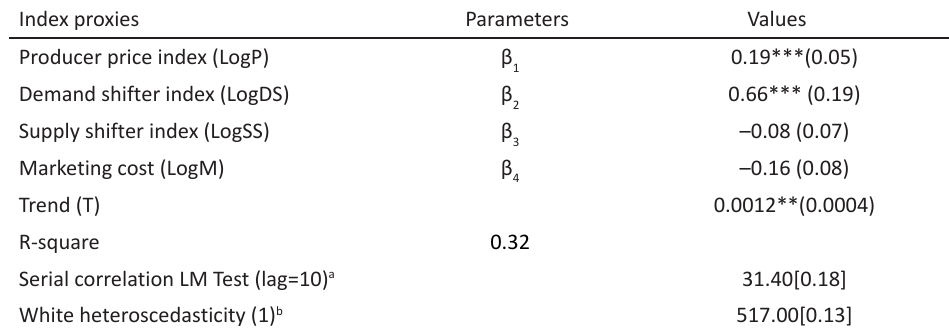
Table 4. Estimated cointegrating vectors (normalised on the retail price index) Index